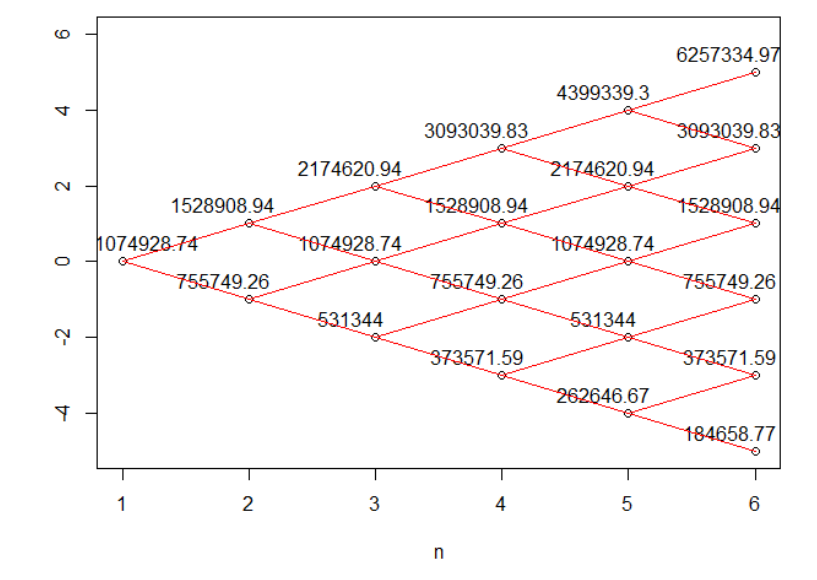
Figure 7. Tree 1 option to wait